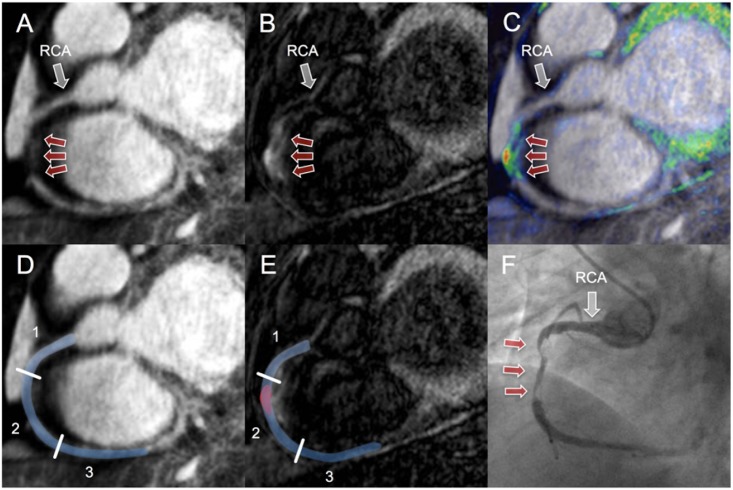
CE-MRCVI findings in a patient with troponin positive ACS in the RCA.Coronary MRA (A) of a 48-year-old male with troponin positive ACS showed decreased vessel lumen size of the mid RCA (red arrows). To highlight the relationship between CE-MRCVI (B) and morphology (A), images were fused in a way similar to PET/CT (C). CE-MRCVI displays high signal intensity (red arrows) within the mid RCA. Analysis of signal enhancement on CE-MRCVI (E, red) suggestive for culprit lesion yielded a contrast-to-noise ratio (CNR) of 12.7. Corresponding XCA (F) confirmed CE-MRCVI findings with mid RCA de-novo lesion (pre-treatment stenosis of 75–94%). MRA: magnetic resonance angiography, CE-MRCVI: contrast enhanced magnetic resonance coronary vessel wall imaging, PET/CT: positron emission tomography/computed tomography. CE-MRCVI:contrast enhanced magnetic resoance coronary vessel wall imaging, ACS: acute coronary syndrome, RCA: right coronary artery, MRA: magnetic resonance angiography, XCA: x-ray coronary angiography, PET/CT: positron emission tomography/computed tomography.